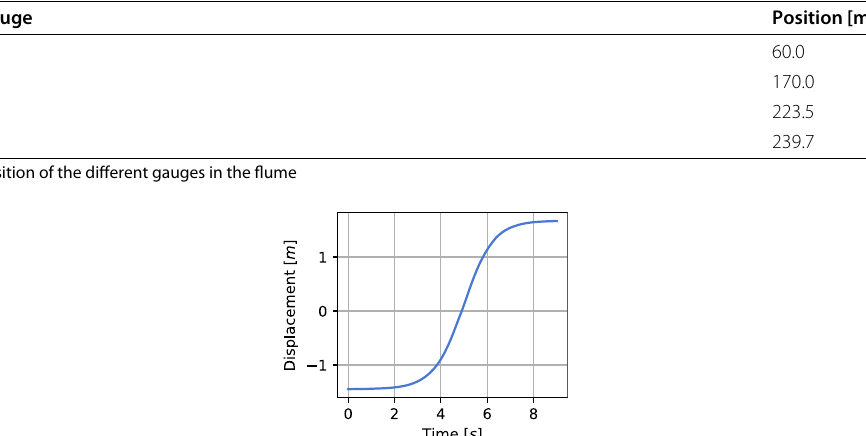
Table 1 Solitary wave example